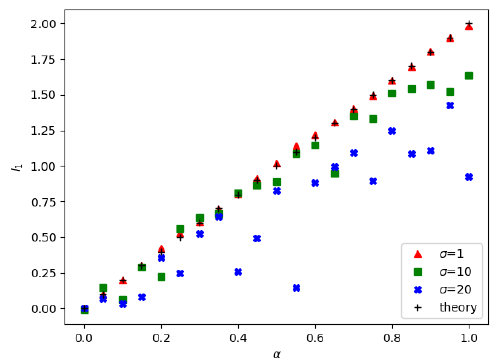
Figure 14. Comparison of coherence: N =